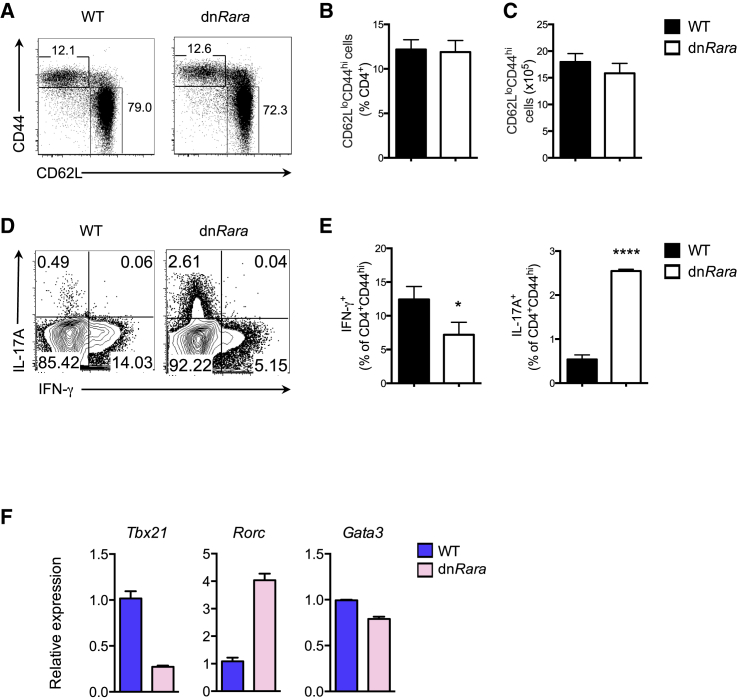
RA Controls the Balance between Th1 and Th17 Effector Cells(A) Splenic CD4+ T cells from dnRara and WT littermate control mice. Numbers indicate percentage CD62LloCD44hi cells (top left) or CD62LhiCD44lo T cells (bottom right) gated on CD4+ cells.(B) Frequency and total number (C) of CD62LloCD44hi in the CD4+ T-cell population in WT and dnRara mice (n = 3 or 4 per group).(D) Intracellular IFN-γ and IL-17A expression in splenic CD4+CD44hi T cells after stimulation with phorbol 12-myristate 13-acetate (PMA) and ionoymycin.(E) Statistical data from cells as in (D).(F) Quantitative real-time PCR analysis of Tbx21, Rorc, and Gata3 in splenic CD4+CD62loCD44hi cells (as in 1A), sorted by flow cytometry.Data are from two or three independent experiments with similar results. Mean ± SEM, ∗p < 0.05; ∗∗∗∗p < 0.0001See also Figure S1.